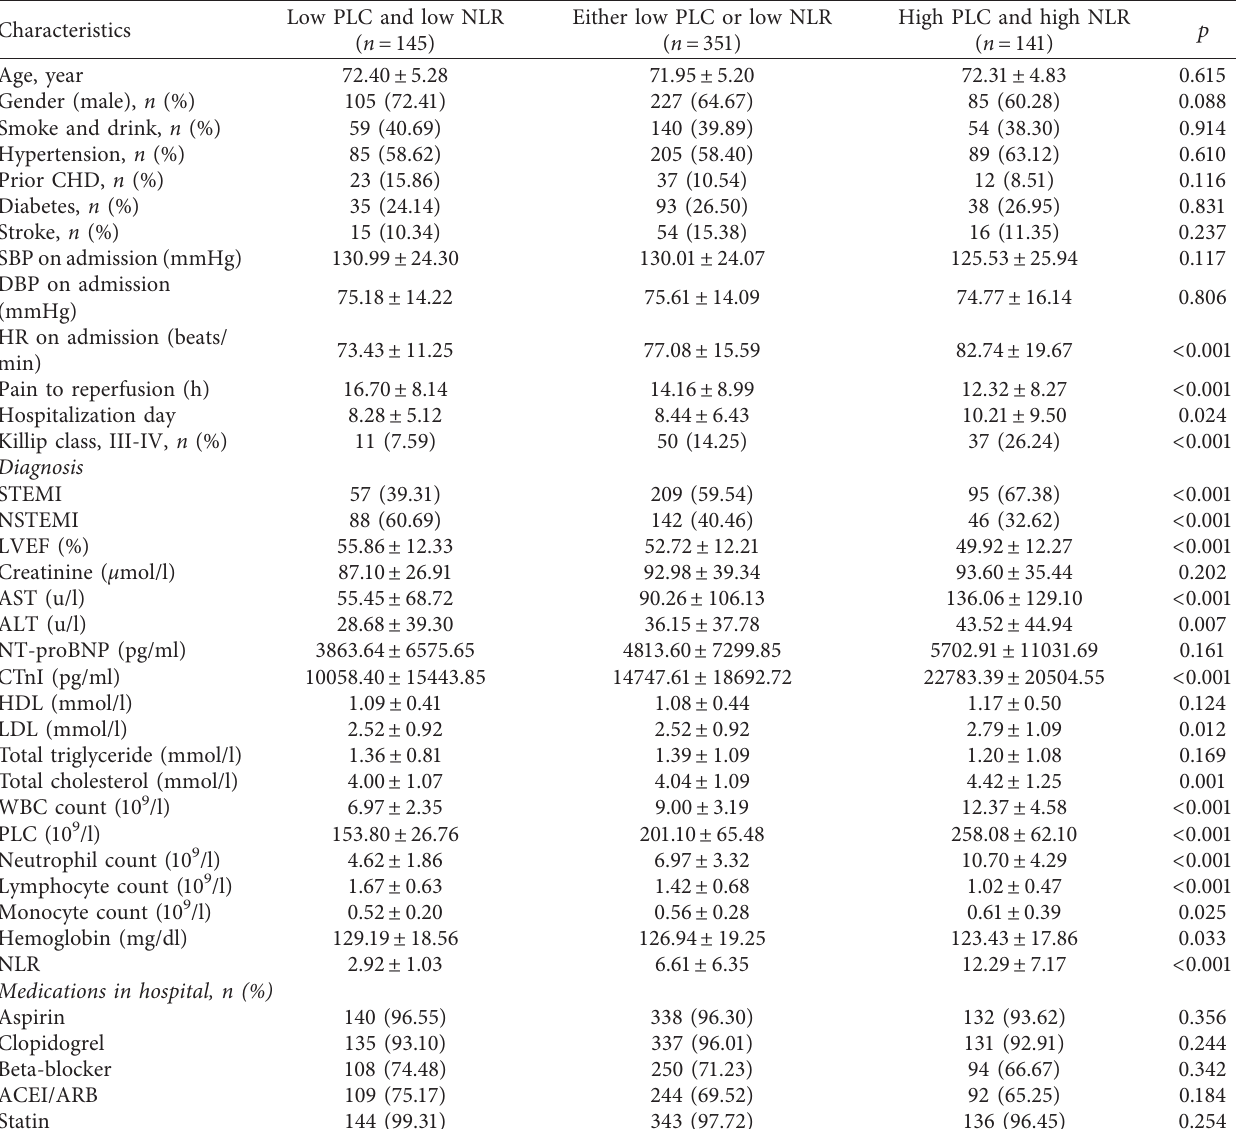
Table 1: Baseline